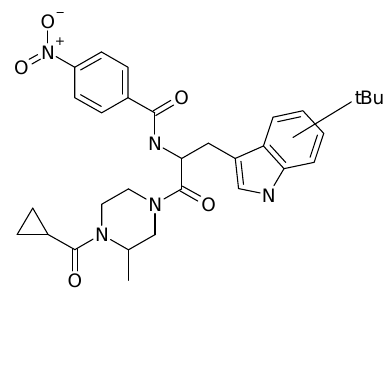
Figure 1. Chemical formula of SP-10, N -[2-(4-cyclopropanecarbonyl-3-methyl-piperazin- 1-yl)-1-( tert -butyl-1 H